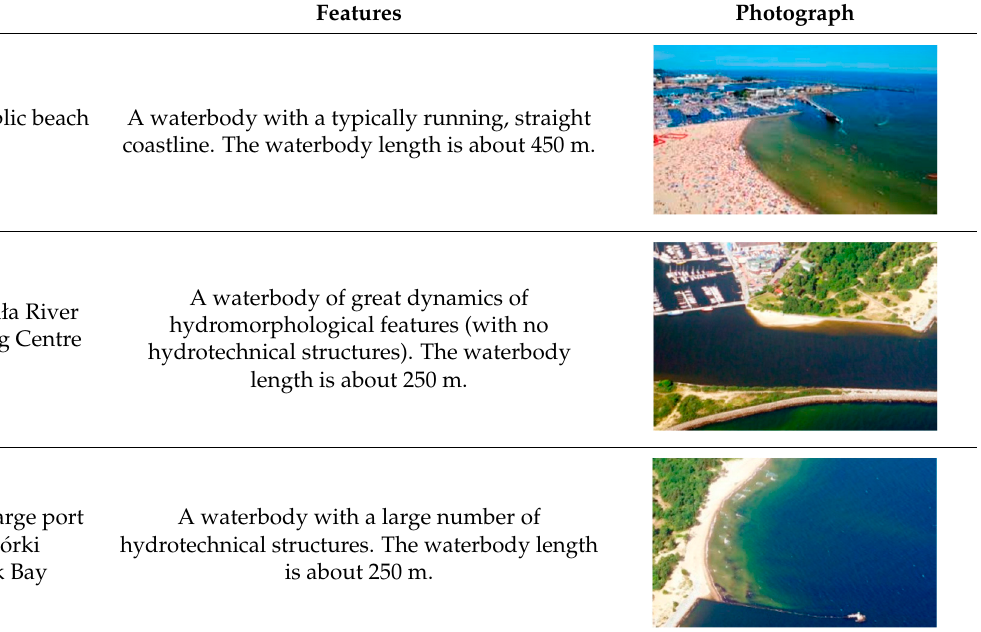
Table 1. Representative waterbodies on which TBS measurements were carried out [44].